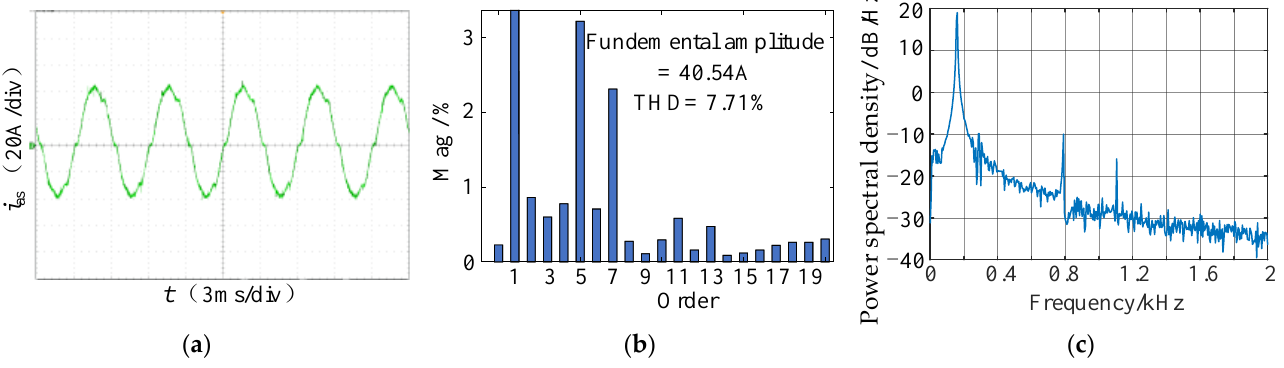
Figure 23. Experimental results under no compensation. ( a ) i as ; ( b ) FFT; and ( c ) power spectral density.